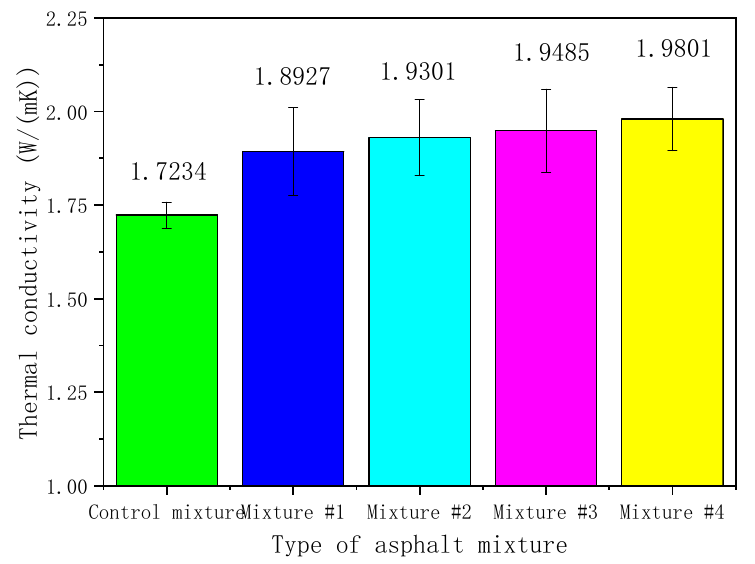
Figure 12. Thermal conductivity of different asphalt mixtures. Table 6. Error statistics results of the thermal conductivity test.